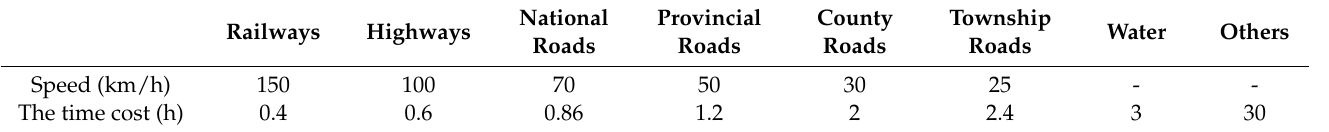
Table 2. Relative time cost settings of different road